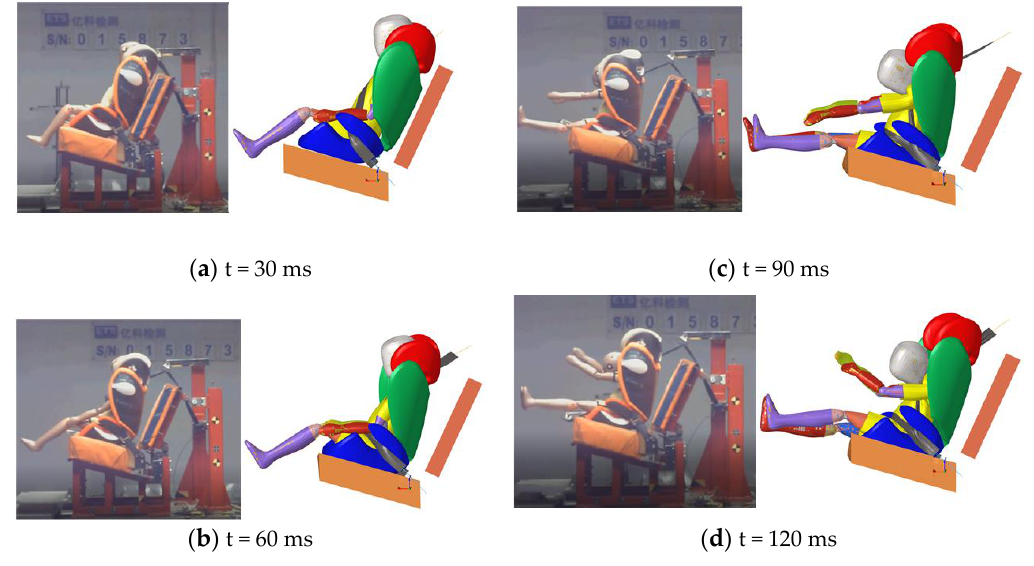
Figure 3. Comparison of child dummy kinematics between simulation and test: ( a ) t = 30 ms; ( b ) t = 60 ms; ( c ) t = 90 ms; ( d ) t = 120 ms.